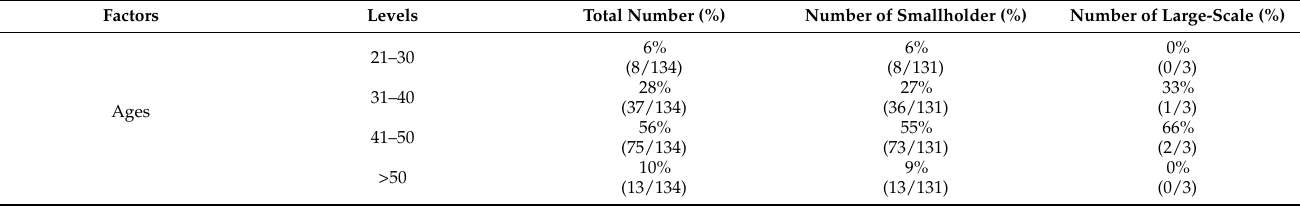
Table 3. Descriptive data of farmers and dairy farms included in the